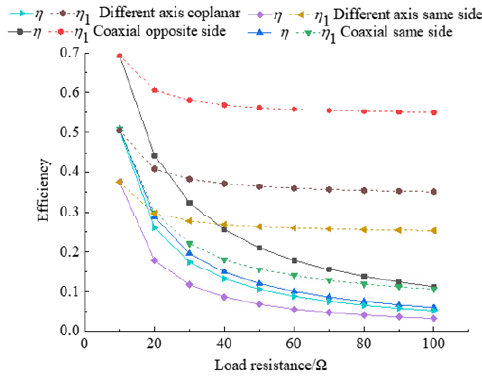
Figure 10. Efficiency curve for load resistance changes.